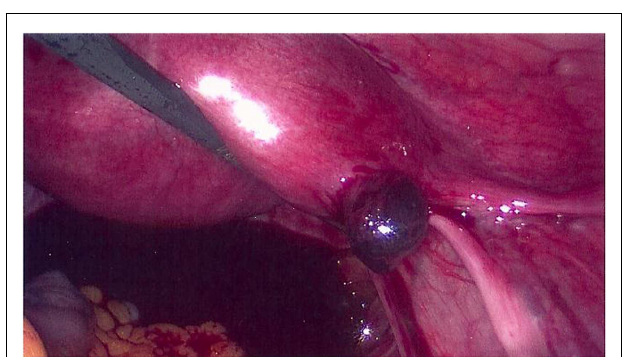
FIGURE 1 | Right interstitial pregnancy after ipsilateral salpingectomy (case 1).